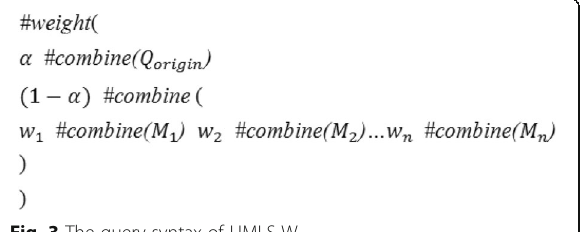
Fig. 3 The query syntax of UMLS-W